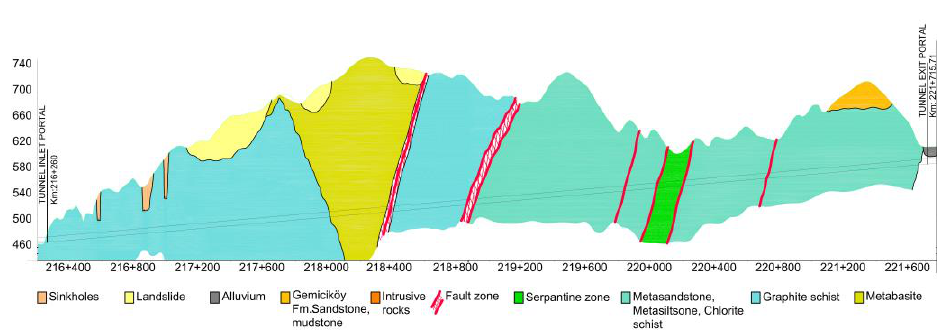
Figure 4. Longitudinal cross-section of the T26 tunnel [36].